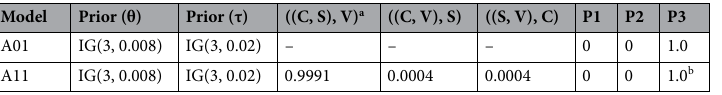
Table 1. Outline of priors and posterior probability results for species delimitation analyses of Hoary bats in BPP. Two analyses were run using a fixed guide tree (A01) and unguided (A11). Two different prior scenarios were examined using five independent runs to ensure parameter convergence based on population size (inverse gamma θ = α, β) and divergence time differences (inverse gamma τ = α, β). For population size, β was estimated from a mutation rate of 2.22 × 10 −9 substitution/site/year 50 . In the possible alternative topologies presented C = L. cinereus , S = L. semotus , and V = L. villosissimus . In A01 analyses, the initial topology was set to match the relationships obtained from the best supported maximum likelihood tree, indicated by a (see Fig. 1). P1–3 indicates the posterior probabilities of species delimitation, from one to three species.